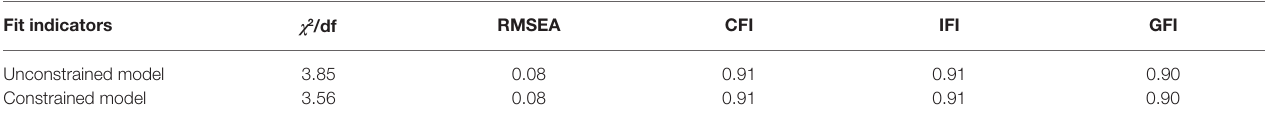
TABLE 4 | Fitness indicators of structural equation models for the gated and open communities.